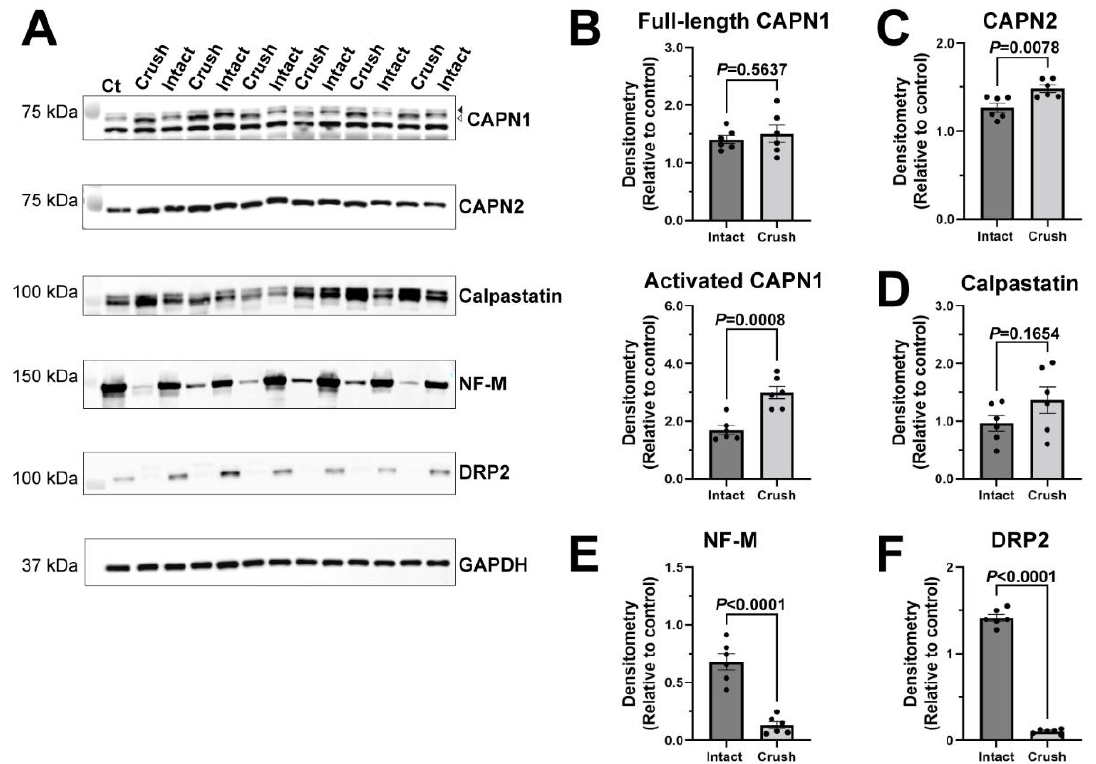
Figure 6. Calpain and calpastatin expression 6 days after a crush injury of rat sciatic nerves. ( A ) Immunoblotting images 6 days after a crush injury. Ct represents a control homogenate from an uninjured nerve of an adult rat to be used as the reference lane. Intact nerves are contralateral sciatic nerves to the crush injury. Full-length CAPN1 (arrowhead at 80 kDa), activated CAPN1 (open arrowhead at 76/78 kDa), CAPN2, and calpastatin levels were examined. Neurofilament (NF)-M expression was examined to determine the extent of axonal damage distal to the crush site, and dystrophin-related protein 2 (DRP2) was examined to determine the amount of myelin loss. GAPDH was examined as an internal loading control. Some molecular weight markers were overlaid to illustrate band locations. ( B – F ) Quantitative analysis of immunoblot data 6 days after a crush injury. Relative density was quantified for the full-length CAPN1 (80 kDa) and CAPN1 activated form (76/78 kDa) ( B ), CAPN2 ( C ), calpastatin ( D ), NF-M ( E ), and DRP2 ( F ). Data are normalized to internal lane loading control (GAPDH). Student’s t -test was used for two group comparisons between the crush-injured nerves and intact contralateral nerves ( B – E ). For DRP2 comparison ( F ), Welch’s t -test was used due to unequal variances according to F test (Supplementary Information S5). Mean ± SEM graphed with n = 6 rats. Detailed results of statistical analyses are provided in the Supplementary Information